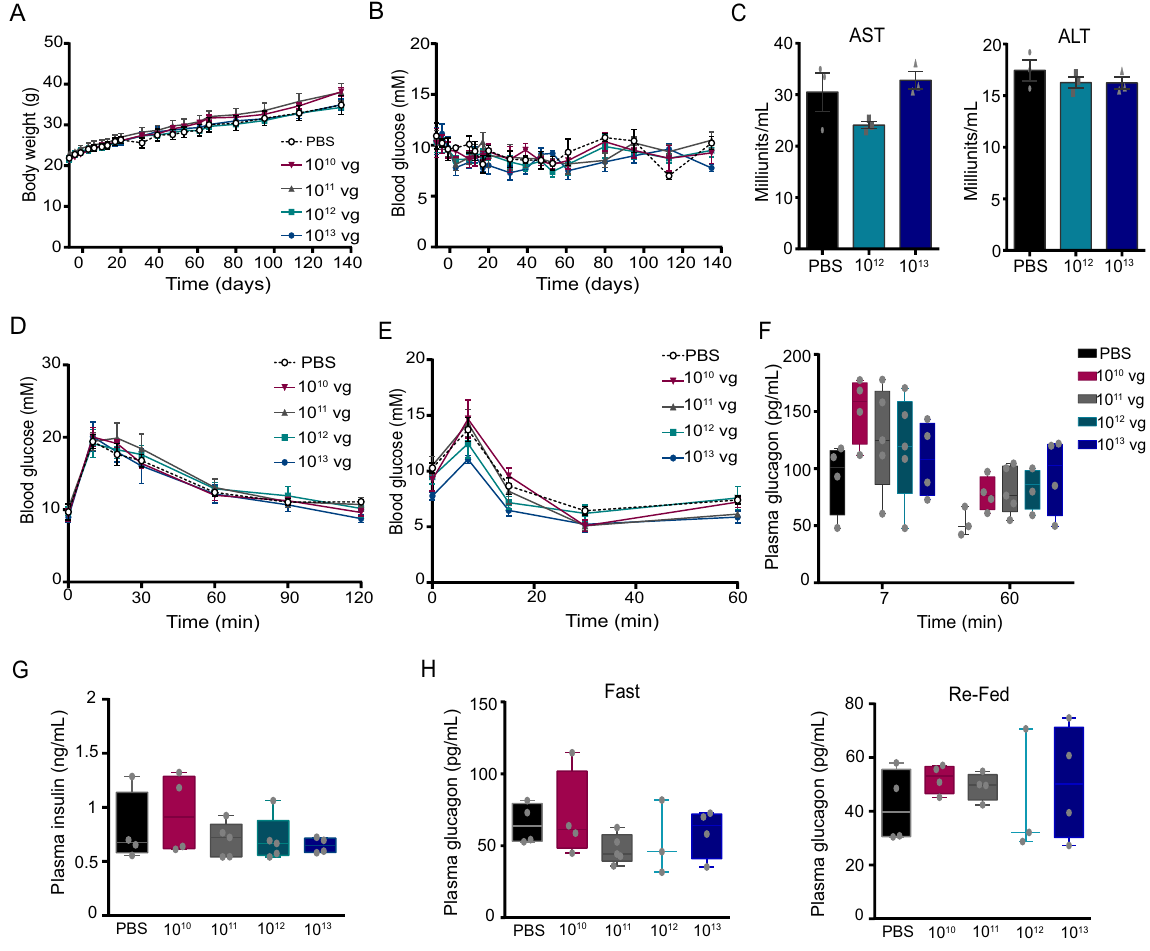
Figure 3. Administration of AAV GCG-EGFP does not alter body weight or glucose homeostasis. Four hour fasted ( A ) body weight and ( B ) blood glucose, before and after intraperitoneal administration of several doses of AAV GCG-EGFP from 10 10 to 10 13 vg on day 0. ( C ) Serum AST and ALT levels 2 weeks post intraperitoneal injection of AAV. ( D ) OGTT was performed following a dextrose load of 1.5 g/kg body weight after a 4 hour fast, 10 weeks after AAV administration. An arginine tolerance test was performed via an arginine injection of 2 g/kg body weight after a 4 hour fast, 13 weeks after AAV injection, with ( E ) blood glucose and ( F ) plasma glucagon levels measured at different timepoints following arginine administration. ( G ) Plasma insulin levels after overnight fasting and ( H ) plasma glucagon levels after overnight fasting and in the re-fed state (2 hr ad libitum feeding) 23 weeks after AAV injection. AST: aspartate aminotransferase; ALT: alanine aminotransferase; vg: viral genomes. Data are expressed as mean ± SEM. Statistical analysis was performed using Kruskal-Wallis Test or two-way ANOVA (no significant differences observed among groups). A, B, D and E, n = 4 in PBS, 10 10 and 10 13 groups, and n = 5 in 10 11 and 10 12